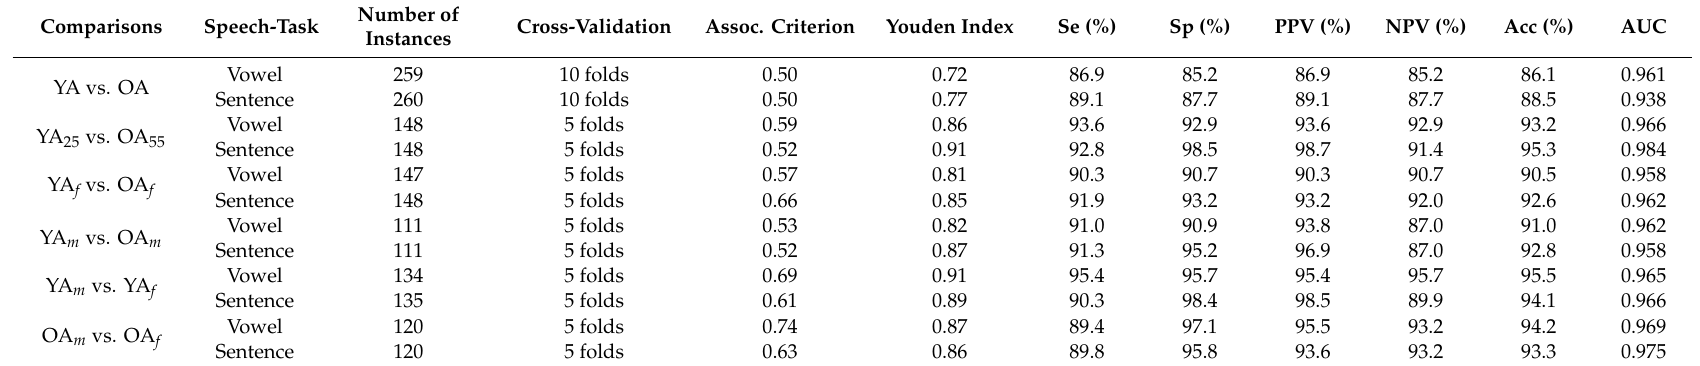
Table 2. Performance of the machine-learning algorithm in all the